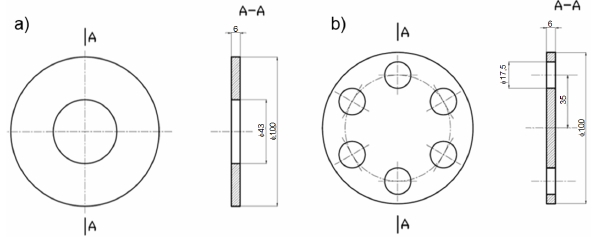
Figure 2: Measuring orifice a) standardized one-hole flange b) multi- hole flange developed by ZPDA from Ostrow Wielkopolski